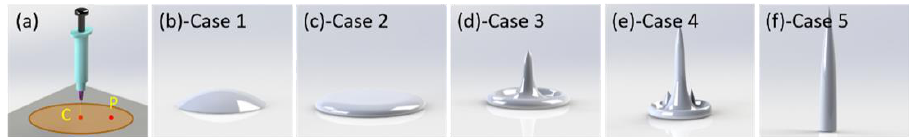
Figure 7. Imaginary schematic of initial fiber deposit shape based on probabilistic jet deposition behavior: ( a ) deposition area under the needle; ( b ) ideal Case 1 without fiber attraction and repulsion; ( c ) Case 2 at low collector temperature with strong repulsion but weak attraction; ( d ) Case 3 at medium collector temperature with comparable attraction and repulsion; ( e ) Case 4 at high collector temperature with strong attraction but weak repulsion; ( f ) Case 5 at super high collector temperature with super strong attraction and little repulsion).